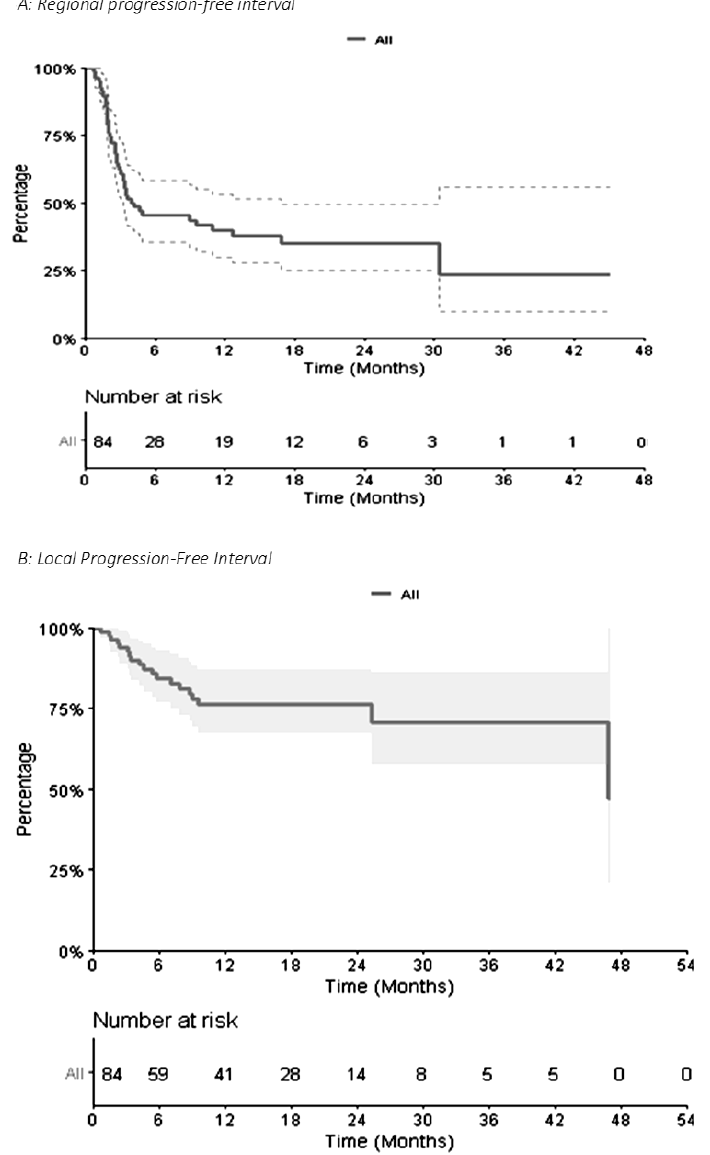
Figure 3. Kaplan–Meier Curve of Regional Progression-Free Interval ( A ) and Local Progression-Free Interval ( B ) for 84 metastases.